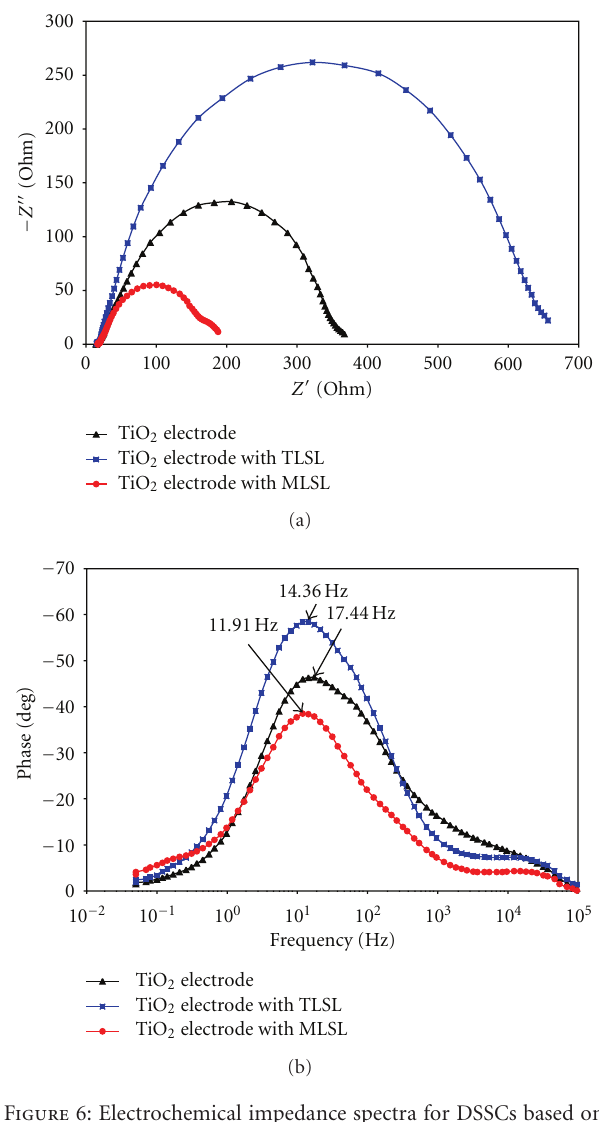
Figure 6: Electrochemical impedance spectra for DSSCs based on di ff erent photo electrodes. (a) Nyquist plot and (b) Bode phase